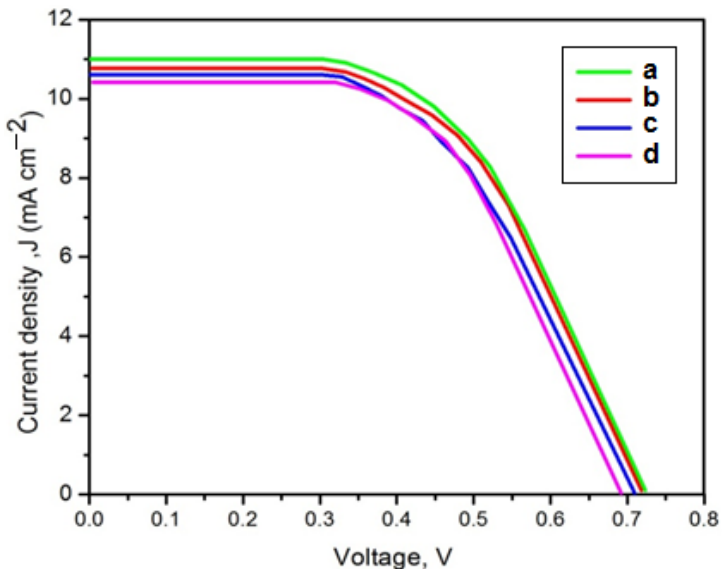
Table 5. Photo-voltaic parameters of fabricated DSSCs composed of different plasticized polymer electrolytes.